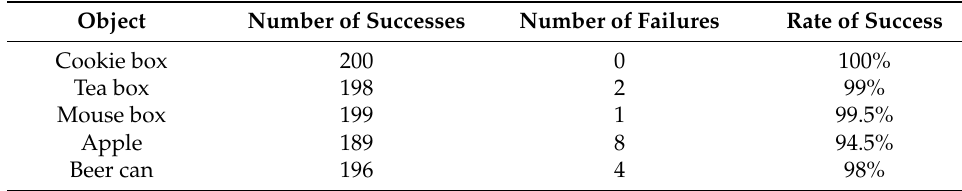
Table 4. Experimental results of single object